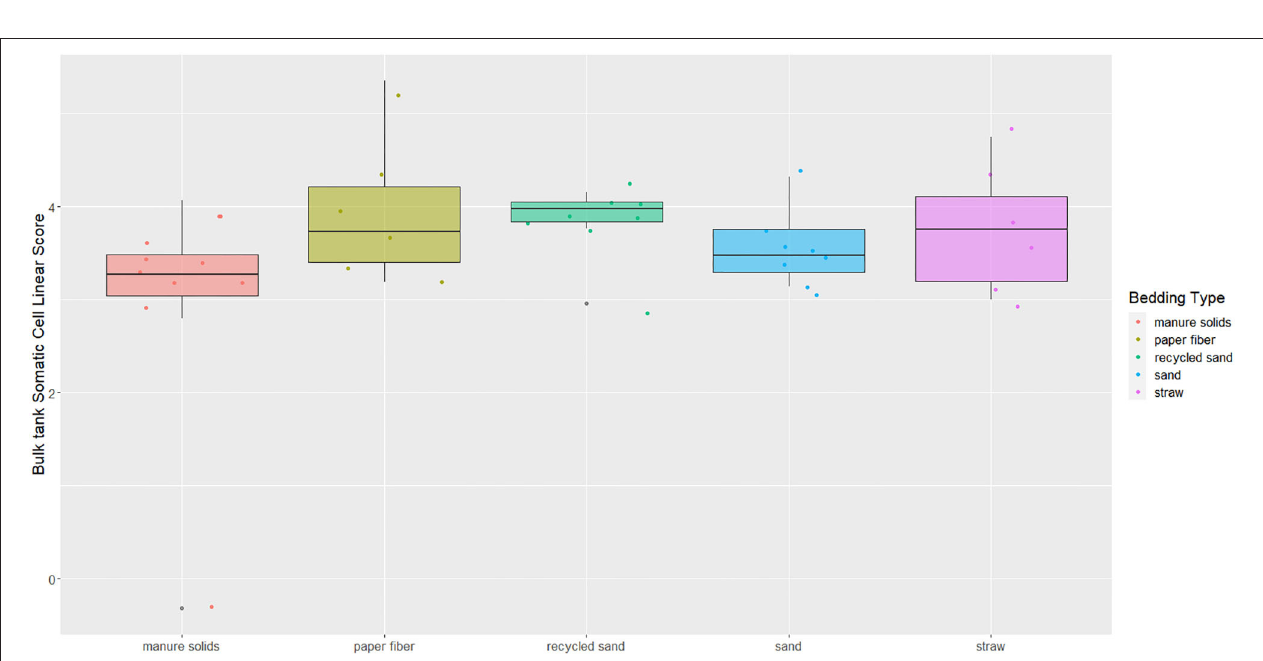
FIGURE 8 | Displayed only the proportion from BT milk samples with detectable organisms of mastitis importance. Milk samples collected monthly (unless milk had been picked up prior to arrival for follow up visit) from the BT after mechanically agitating the milk for at least 5min until sufficient homogeneity is obtained from five conveniently selected New York dairy herds using one of five bedding materials in lactating pens.